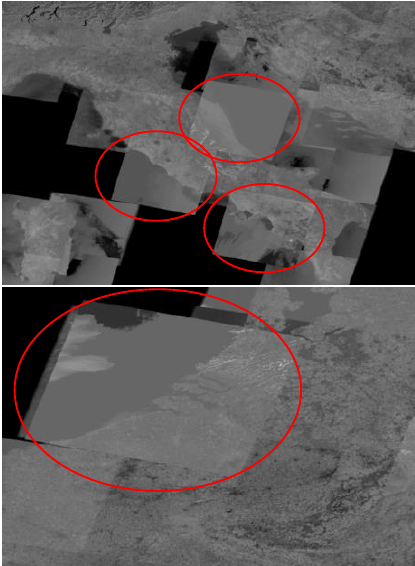
Figure 6. Zoomed views to radiometric differences between Landsat 7 and 8. Landsat 5 and 7 Band 4 together with Landsat 8 Band 5 images were used for mosaicking process.